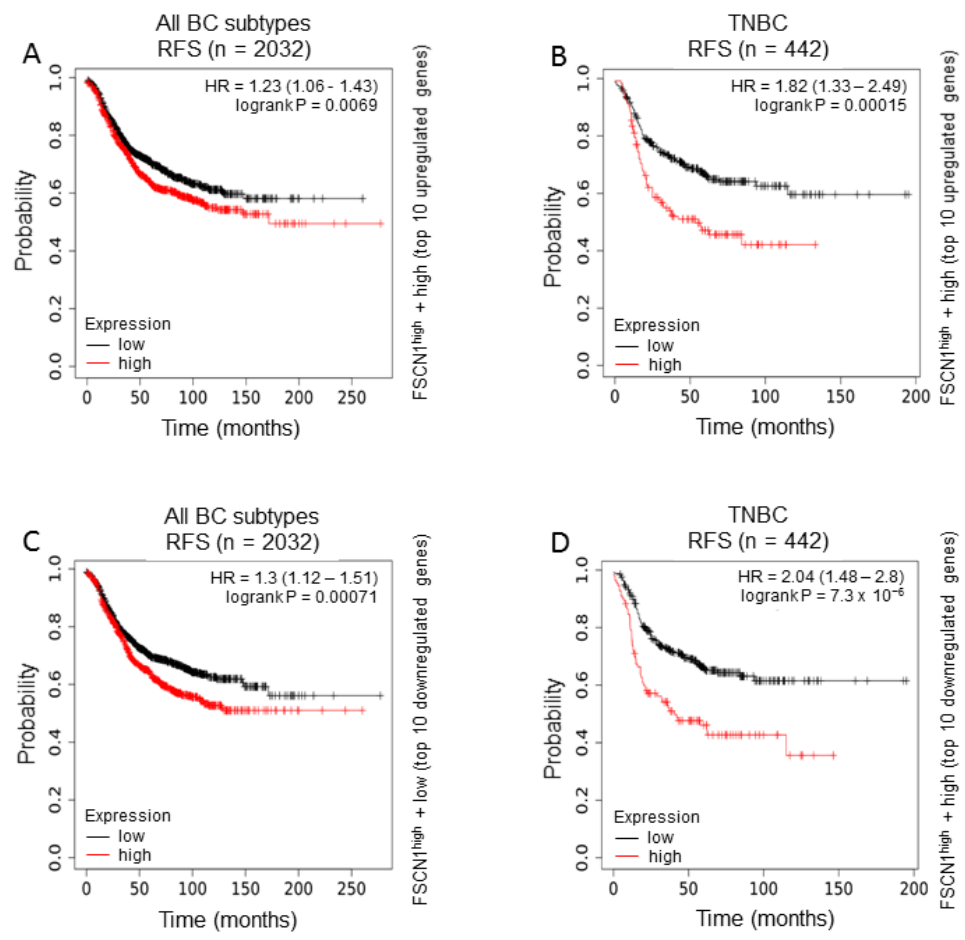
Figure 4. Effect of the differentially identified genes in MDA-MB-231 breast cancer cells on survival of FSCN1 high compared to FSCN1 low breast cancer patients from TCGA dataset. Kaplan-Meier plots from TCGA dataset showing survival of ( A , C ) all breast cancer subtypes (RFS; n = 2032) or ( B , D ) TNBC subtype (RFS; n = 442). Survival of FSCN1 high in conjunction with ( A , B ) high expression of the top 10 upregulated genes or ( C , D ) low expression of the top 10 downregulated genes identified in FSCN1 CON MDA-MB-231 cells. The significance between FSCN1 high and FSCN1 low groups was calculated using the log-rank test. p -values are indicated on each plot.